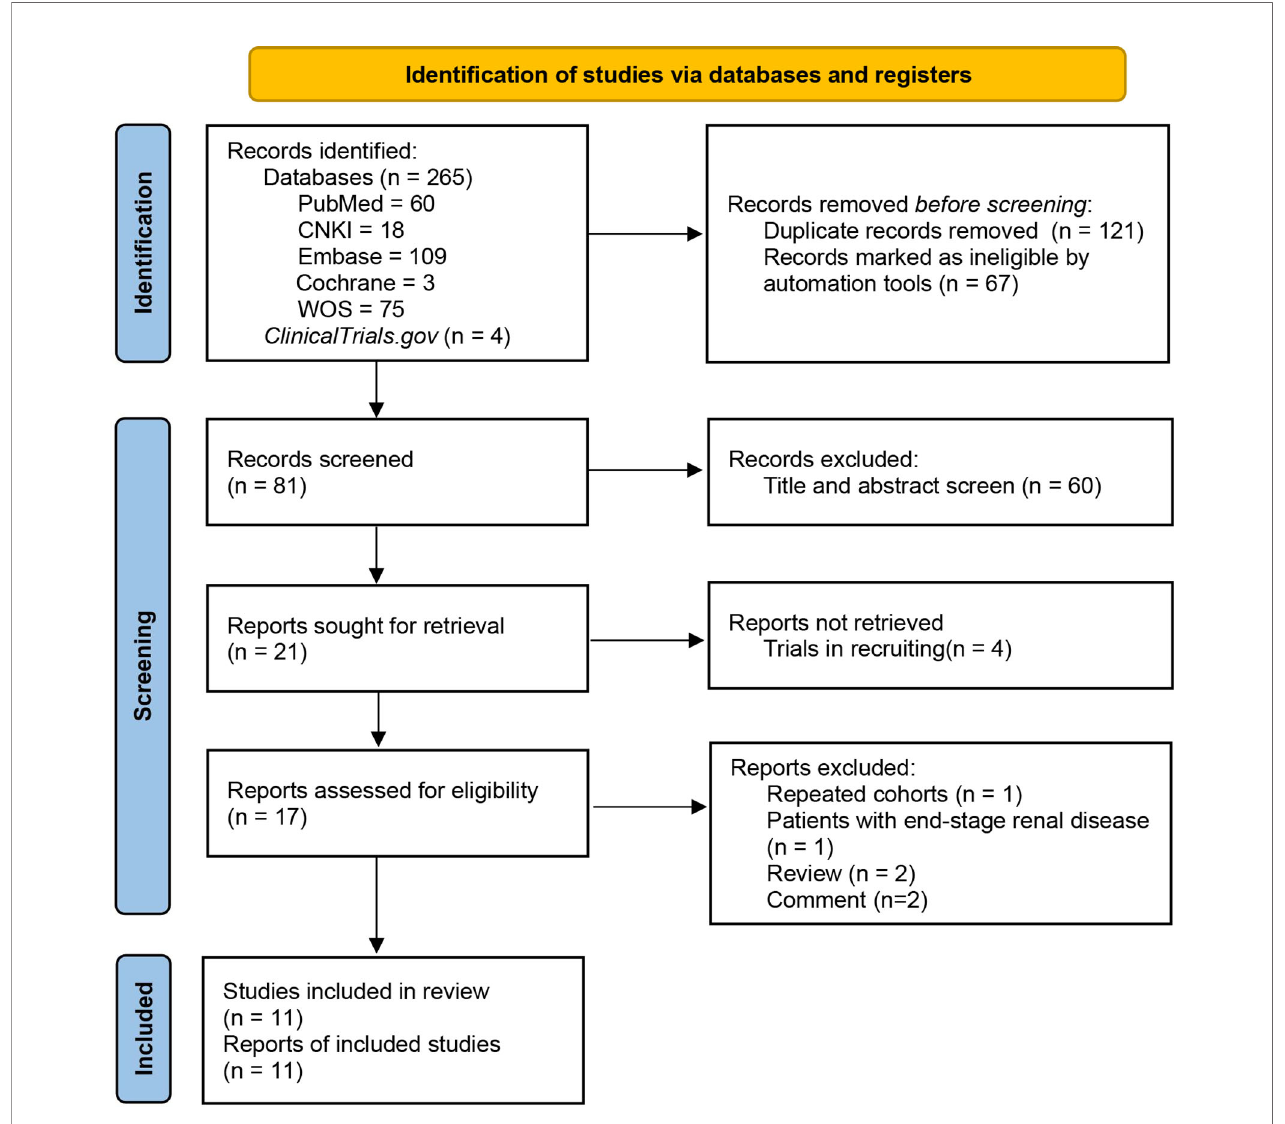
FIGURE 1 | PRISMA fl ow diagram of study identi